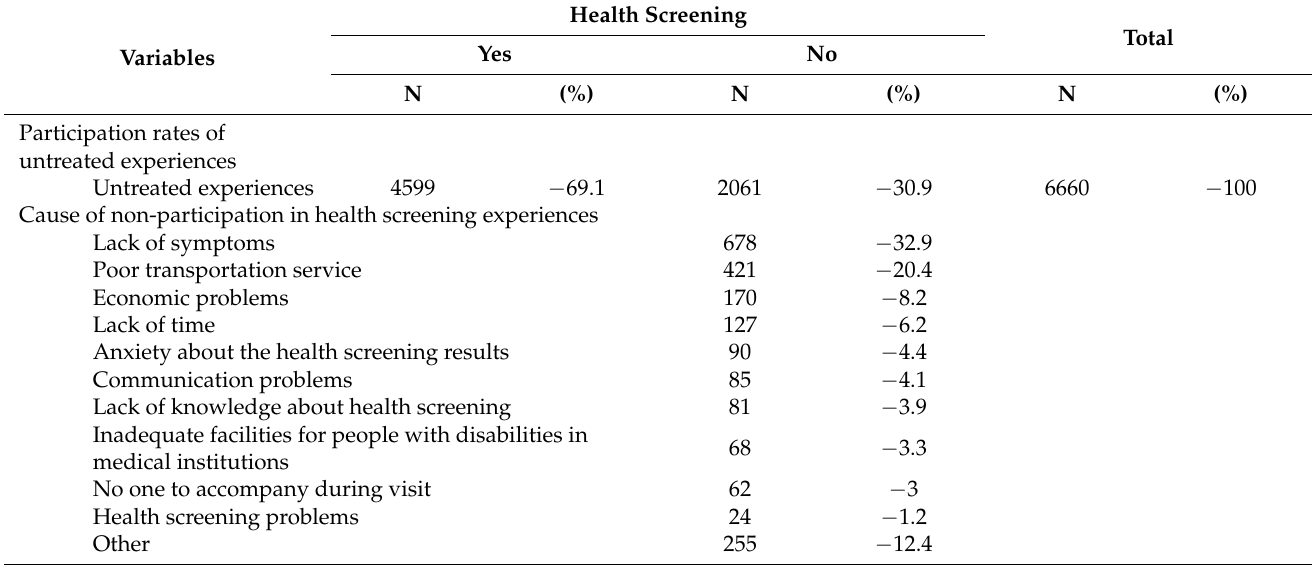
Table 2. Participation rates and cause of non-participation in health screening